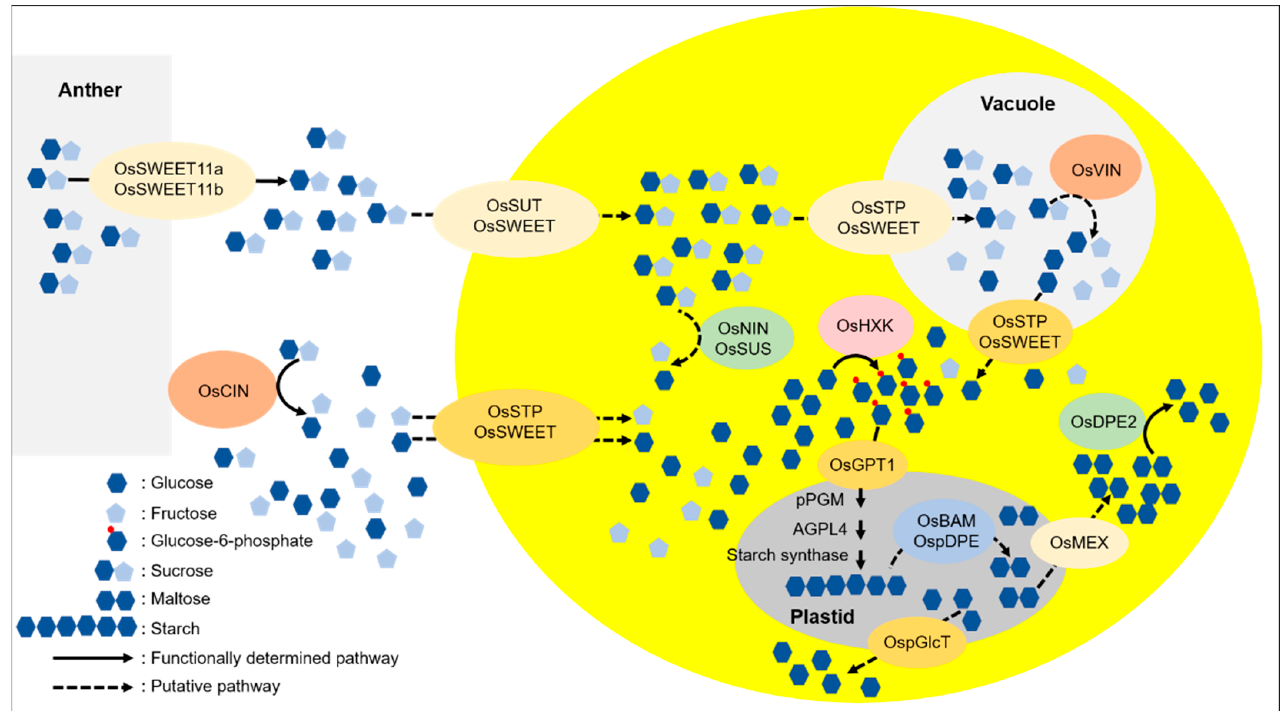
Figure 2. Proposed model of sugar and starch metabolic pathways in rice anther and pollen.